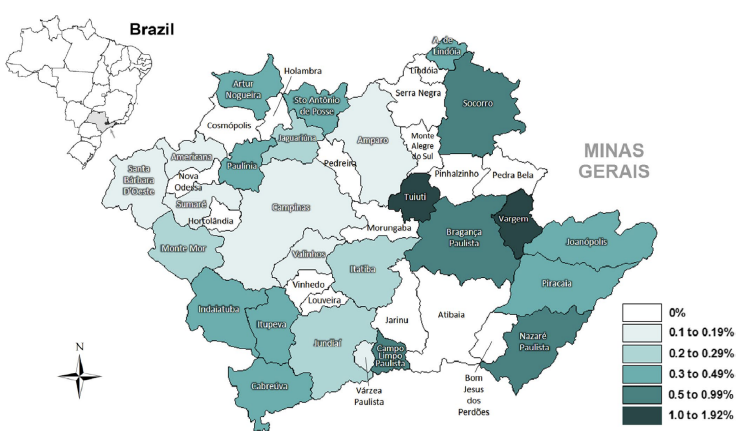
Figure 10. Three-dimensional scalar field visualization of the frequency of newborn carriers of the TP53 p.Arg337His germline mutation in 42 cities from the São Paulo State’s VII Regional Health Board (RHB VII). The São Paulo State is represented in gray color, and the RHB-VII region is indicated by an arrow in a map of Brazil at the left. The zoomed RHB-VII region was depicted in gradient colors representing the range of estimated mutation frequency in each